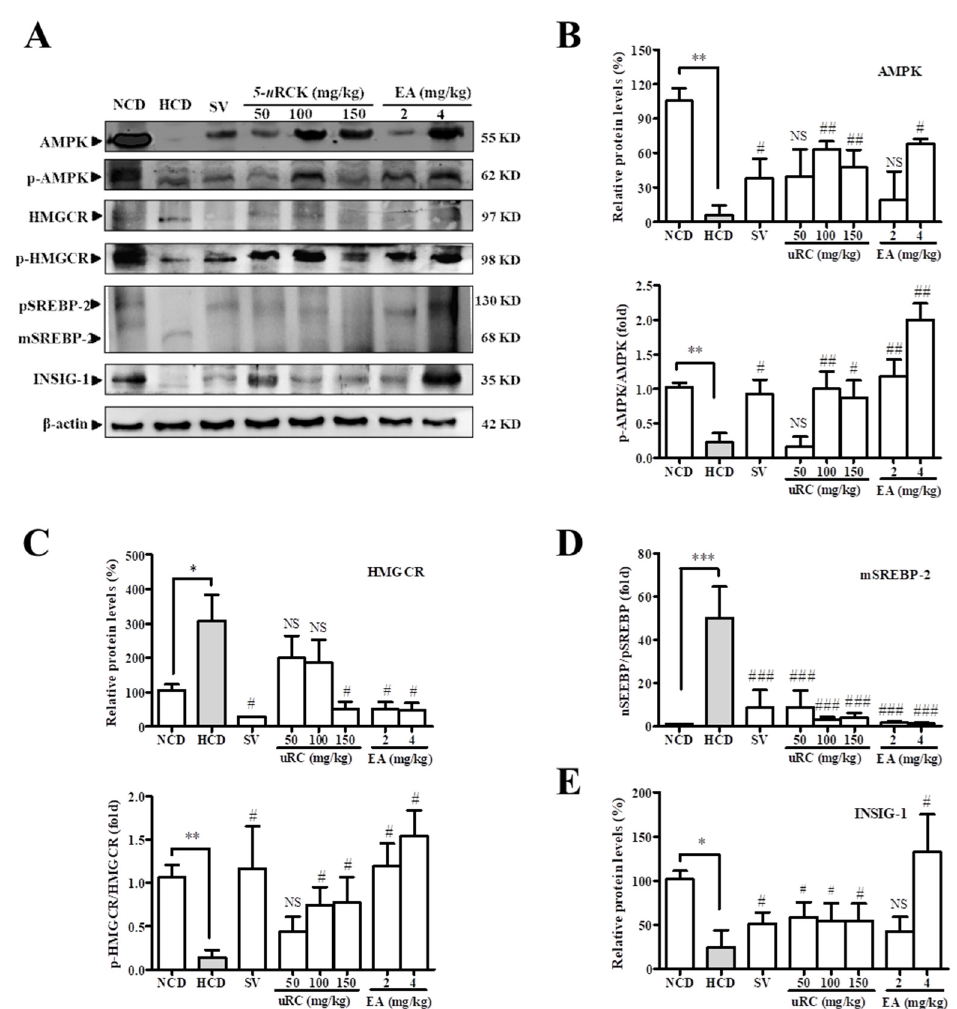
Figure 8. E ff ects of 5- u RCK or ellagic acid (EA) on the phosphorylation of AMPK and the expression of cholesterol biosynthesis-related proteins in the livers of rats fed an HCD. ( A ) The protein expression levels of p-AMPK, AMPK, p-HMGCR, HMGCR, precursor SREBP-2 (pSREBP-2), mature SREBP-2 (mSREBP-2), and INSIG-1 in liver tissues were measured by Western blotting. ( B ) The bar graphs indicate the average p-AMPK and AMPK levels. ( C) The bar graphs indicate the average p-HMGCR and HMGCR levels. ( D ) The bar graph indicates the average pSREBP-2 and mSREBP-2 levels. ( E ) The bar graph indicates the average INSIG-1 levels. The data are expressed as the mean ± SD. P values for comparisons with control groups (NCD groups) are denoted as * p < 0.05, ** p < 0.01 and *** p < 0.001, and those for comparisons with HCD groups are denoted as # p < 0.05, ## p < 0.01, and ### p < 0.001.